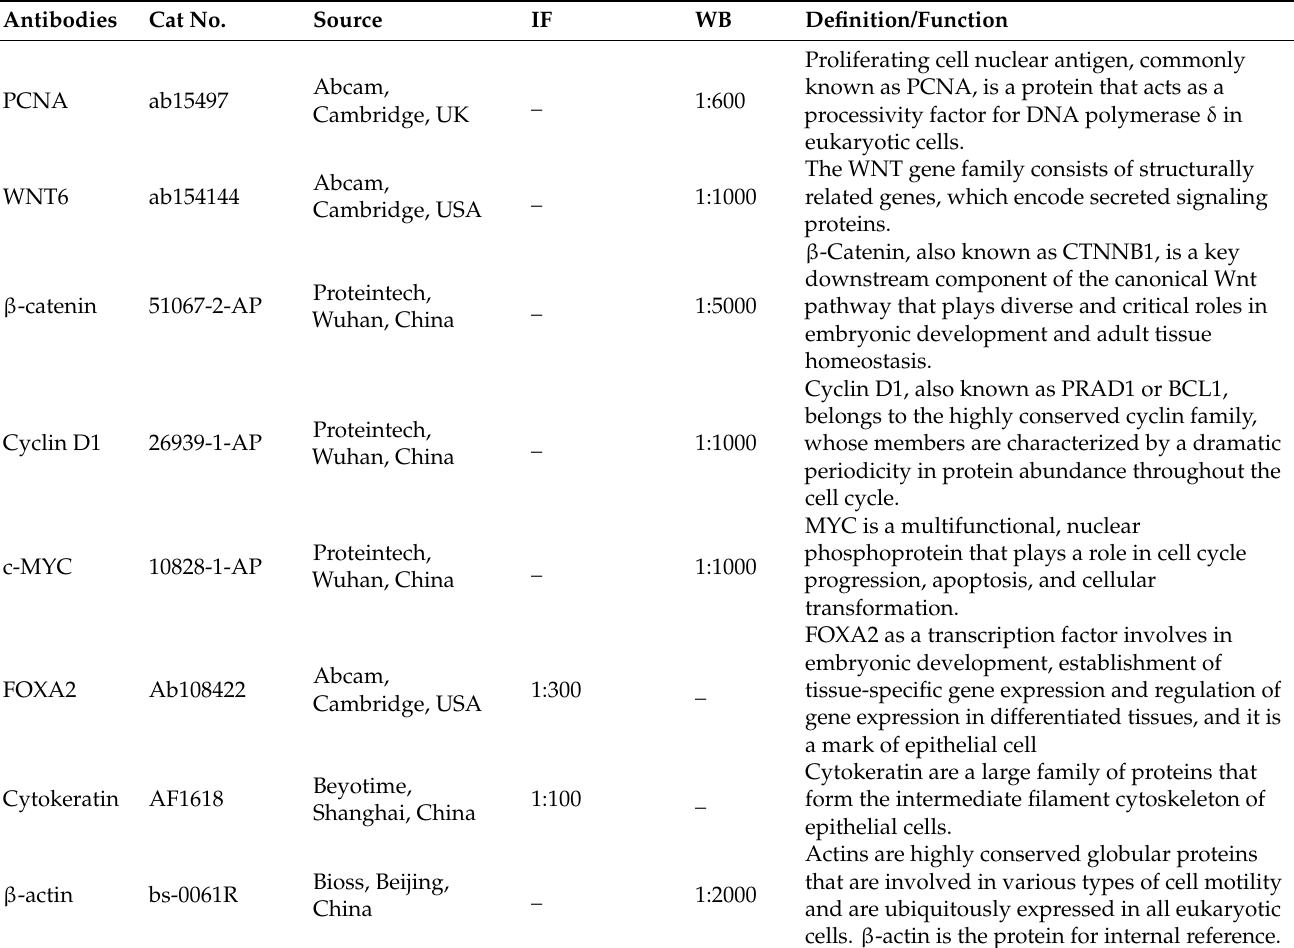
Table 1. Details of